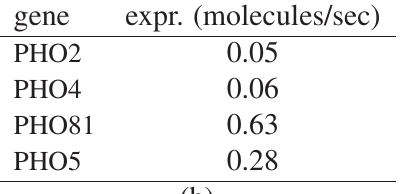
(a) reflects the low phos- q SBP m,lp